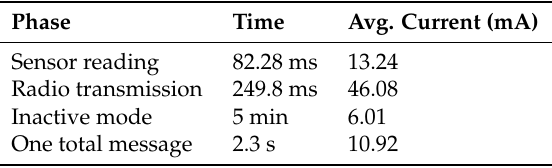
Table 8. Power consumption analysis for LoRaWAN message used for the Greenhouse monitoring